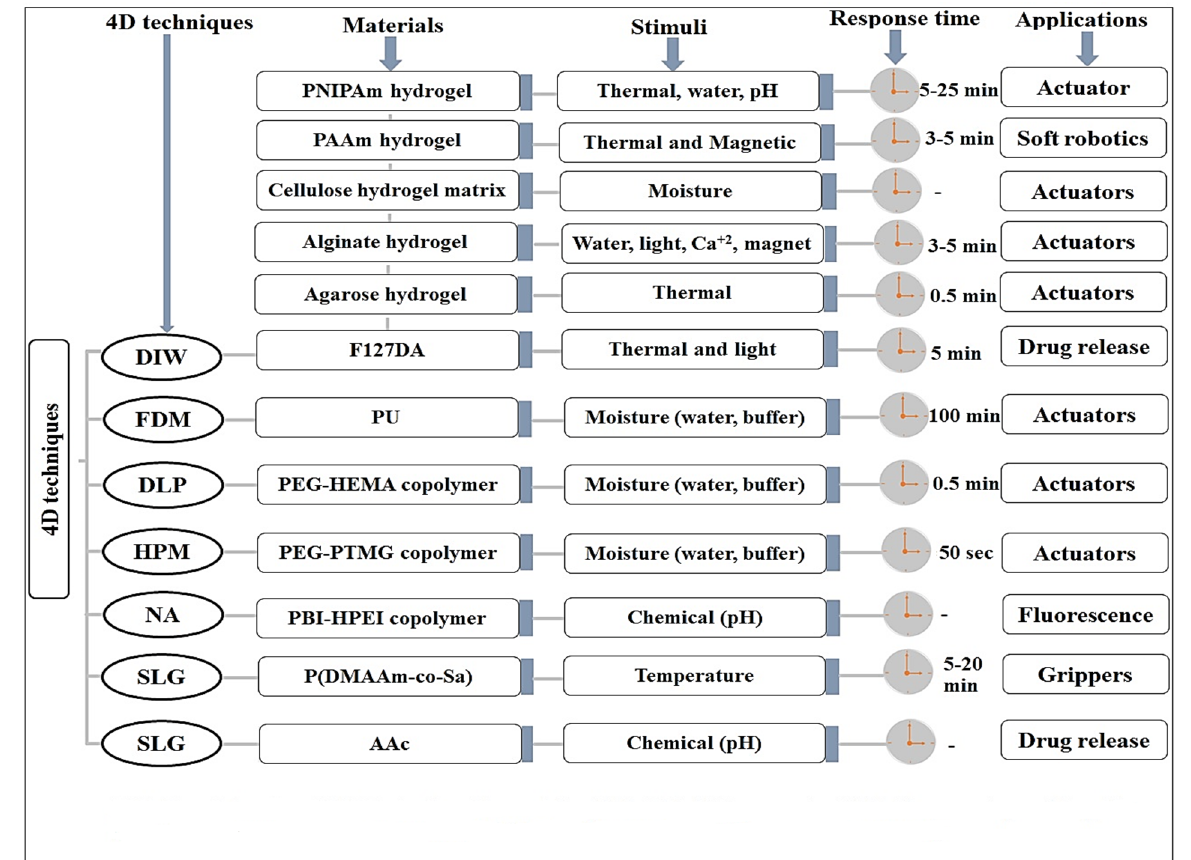
Figure 3. Illustration of various 4D hydrogel fabrication techniques, SMHs, stimuli, response time, and biomedical application (use). DIW: Direct ink writing, FDM: Fusion deposition modeling, ME: Microextrusion, SLG: Stereolithography, DLP: Digital light processing, NA: Not applied, HPM: Hot processing modeling [110].